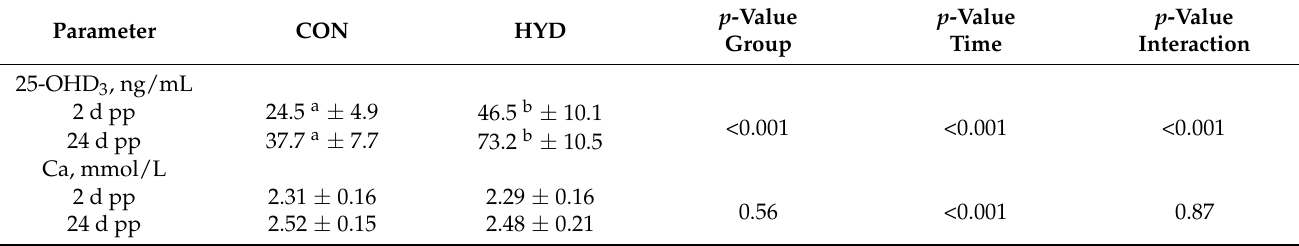
Table 4. Effect of dietary vitamin D source on plasma concentrations of 25-OHD 3 , Ca, P i , CrossLaps, osteocalcin and osteocalcin/CrossLaps ratio of sows at 2 and 24 d pp; mean ± SD and results of a Repeated Measures ANOVA. Different superscripts within a row indicate significant differences between groups at a certain day revealed by Holm–Sidak ´ s